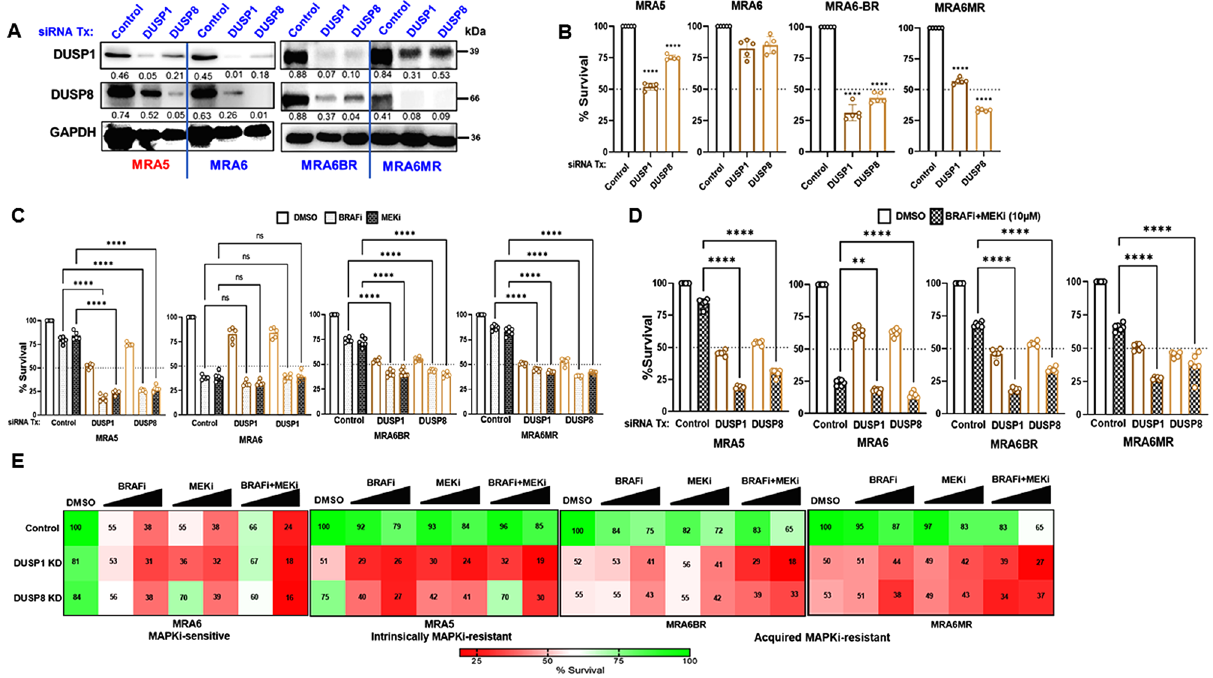
Figure 3. Effect of DUSP1 and DUSP8 knockdown on MAPKi-sensitivity. ( A ) Intrinsically MAPKi-resistant MRA5, MAPKi-sensitive MRA6 cells and MRA6 cells with acquired resistance MRA6BR, MRA6MR cells were transfected with DUSP1 and DUSP8 Misson® esiRNAs or control siRNA, harvested at 72 h and western blot analysis was performed using anti-DUSP1 and DUSP8 antibodies. GAPDH was used as loading control. ( B ) Survival of DUSP1 (dark brown bars) or DUSP8 (light brown bars) siRNA transfected cells was assessed by MTT assay and data are shown as percent survival of control siRNA transfected cells. ( C ) MAPKi-sensitive and MAPKi-resistant cells were transfected with DUSP1 and DUSP8 siRNAs. Cells were trypsinized 24 h post- transfection and 5000 cells were seeded in 96-well plates in 5–6 replicate wells and treated for 48 h with DMSO or 10 µM PLX4032 or 10 µM AZD6244. ( D ) MAPKi-sensitive and MAPKi-resistant melanoma cells were transfected with DUSP1 and DUSP8 siRNAs and treated with DMSO or combination of PLX4032 + AZD6244 as described above in (C). Data are shown as mean ± SD and the data were analyzed using Student’s t-test. P values: * denotes P ≤ 0.05, ** ≤ 0.01; *** ≤ 0.001 and **** ≤ 0.0001. Differences in survival between DMSO treated control siRNA transfected and DMSO treated DUSP siRNA group were all statistically significant ( P values: **** ≤ 0.0001). To minimize crowding of the graphs with lines, these comparisons are not shown but shown in Suppl Fig. 2. For comparison, dotted line shows 50% survival. ( E ) MAPKi-resistant and MAPKi- sensitive melanoma cells were transfected with DUSP1 and DUSP8 siRNAs. Cells were trypsinized 24 h post-transfection and 5000 cells were seeded in 5–6 replicate wells in 96-well plates and treated for 48 h with DMSO or 2.5 µM PLX4032, AZD6244 or 10 µM PLX4032, AZD6244 (MRA5 and MRA6 cells). Or combination of PLX4032 + AZD6244. Data are shown as mean ± SD and analyzed using Student’s t-test. P values: * denotes P ≤ 0.05, ** ≤ 0.01; *** ≤ 0.001 and **** ≤ BRAFi-resistant MRA6BR. Overall, the pattern of expression of DUSPs tested in this study and the effect of BRAFi and MEKi on their expression suggest a varied relationship between DUSPs and MAPKi resistance. Role of DUSP1 and DUSP8 and MAPKi-resistance. To understand the role of DUSPs in melanoma cell survival, we used siRNA-mediated knockdown (KD) of DUSP1 or DUSP8, employing MISSION® esiR- NAs (Millipore Sigma), which are endoribonuclease prepared heterogeneous pools of siRNA that all target the same mRNA sequence. These multiple silencing triggers are reported to lead to highly specific and effective gene silencing. These siRNAs efficiently reduced the levels of respective targets (Fig. 3A and Supp Fig. S2A). DUSP1 KD reduced the survival of MAPKi-resistant MRA5, MRA6BR and MRA6MR cells by 45, 75, and 40%, respectively, whereas DUSP8 KD reduced their survival by 25, 55, and 70%, respectively. Interestingly, DUSP1 or DUSP8 KD had only modest effect (20% and 15% decrease, respectively) on the survival of MAPKi-sensitive MRA6 cells (Fig. 3B). These data indicate that DUSP1 and DUSP8 contribute to the survival MAPKi resistant cells. Next, we investigated the effect of DUSP1 and DUSP8 KD on MAPKi sensitivity of melanoma cells. We trans- fected MAPKi-resistant MRA5 and MAPKi-sensitive MRA6 metastatic melanoma cells with control or DUSP1 or DUSP8 siRNA and then treated the cells with 10 μM BRAFi or MEKi alone or in combination. As shown in Fig. 3C, DUSP1 or DUSP8 KD sensitized the drug resistant MRA5, MRA6BR and MRA6MR cells to MAPKi, i.e., compared to < 20–25% decrease in survival of control siRNA transfected cells, treatment of DUSP1 and